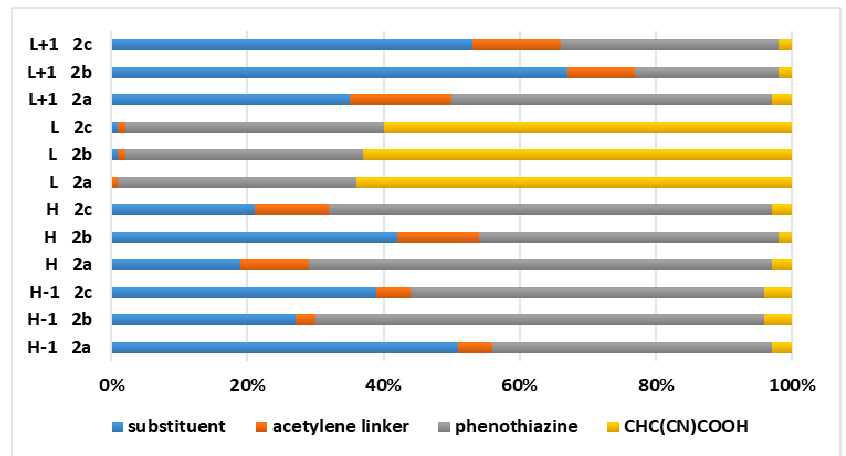
Figure 2. The contributions of particular parts of molecules 2a–2c to the creation of selected orbitals.